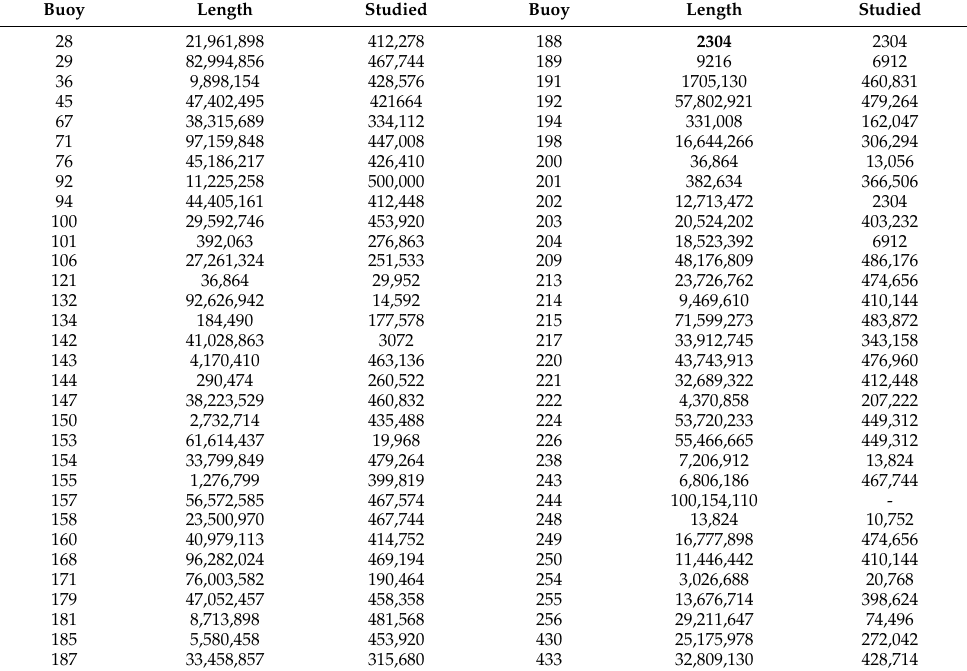
Table 2. The 64 available buoys are labeled by a number, displayed in ascending order. It is also presented the length of the associated raw time series. The smallest length value is depicted in bold. Under the studied label, it is the length of the raw time series under study after restricting it to the first 500,000 time points, in the 54 cases that the length is larger than this value, and eliminating the unobserved